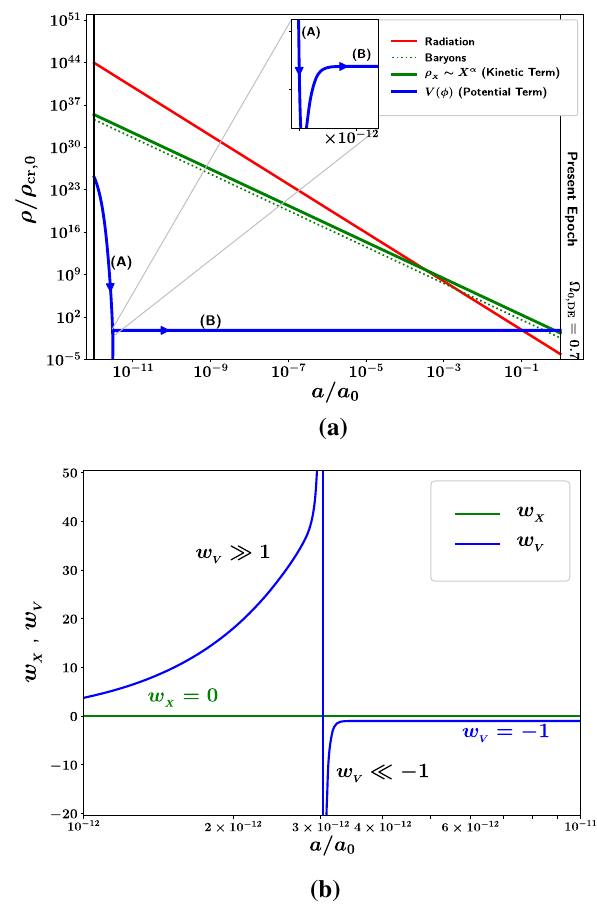
Fig. 8 a The density of radiation (red curve), baryons (dotted green curve) and the non-canonical scalar field are shown for the Starobinsky- type potential (33) with λ = 1. The solid green curve shows the evo- ∝ X α which behaves like dark matter lution of the kinetic term ρ X throughout the history of the universe. The solid blue curve shows the evolution of the potential V (φ) . Note that V (φ) rapidly decreases as φ rolls down the exponentially steep left wing (A) of the potential. This results in V (φ) falling to zero (at φ (cid:2) 0) and then increasing to V 0 , as φ commences to roll along the flat right wing (B); see Fig. 6. Since ρ ∝ a − 3 , the late time expansion in this model resembles Λ CDM. b X The equation of state of the kinetic term ( w ) and the potential term X ( w ) are shown for the transition region when the scalar field rolls from V the steep left wing (A) onto the flat right wing (B) of the potential (33). The change in slope of the potential at φ (cid:2) 0 leads to a pole-like sin- gularity in w . (Note that w as defined in (29) is an effective quantity V V hence its value can exceed unity.) By contrast the EOS of state of the = kinetic term remains pegged at w X